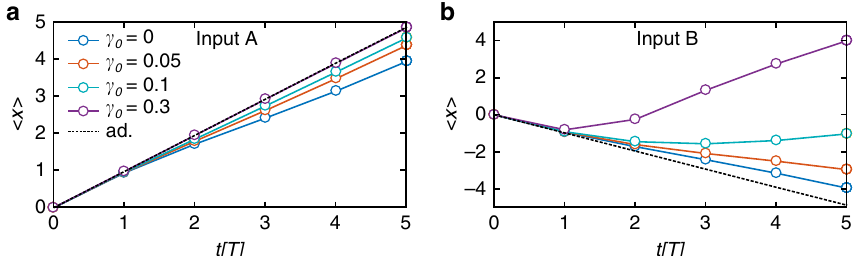
Fig. 3 The center-of-mass shift in the NH RM model. The center-of-mass position of the injected wavepacket after up to 5 full pumping cycles ( Ω = 1.1 J 0 ) at different loss amplitudes γ 0 for a single-site input on ( a ) sublattice A and ( b ) sublattice B